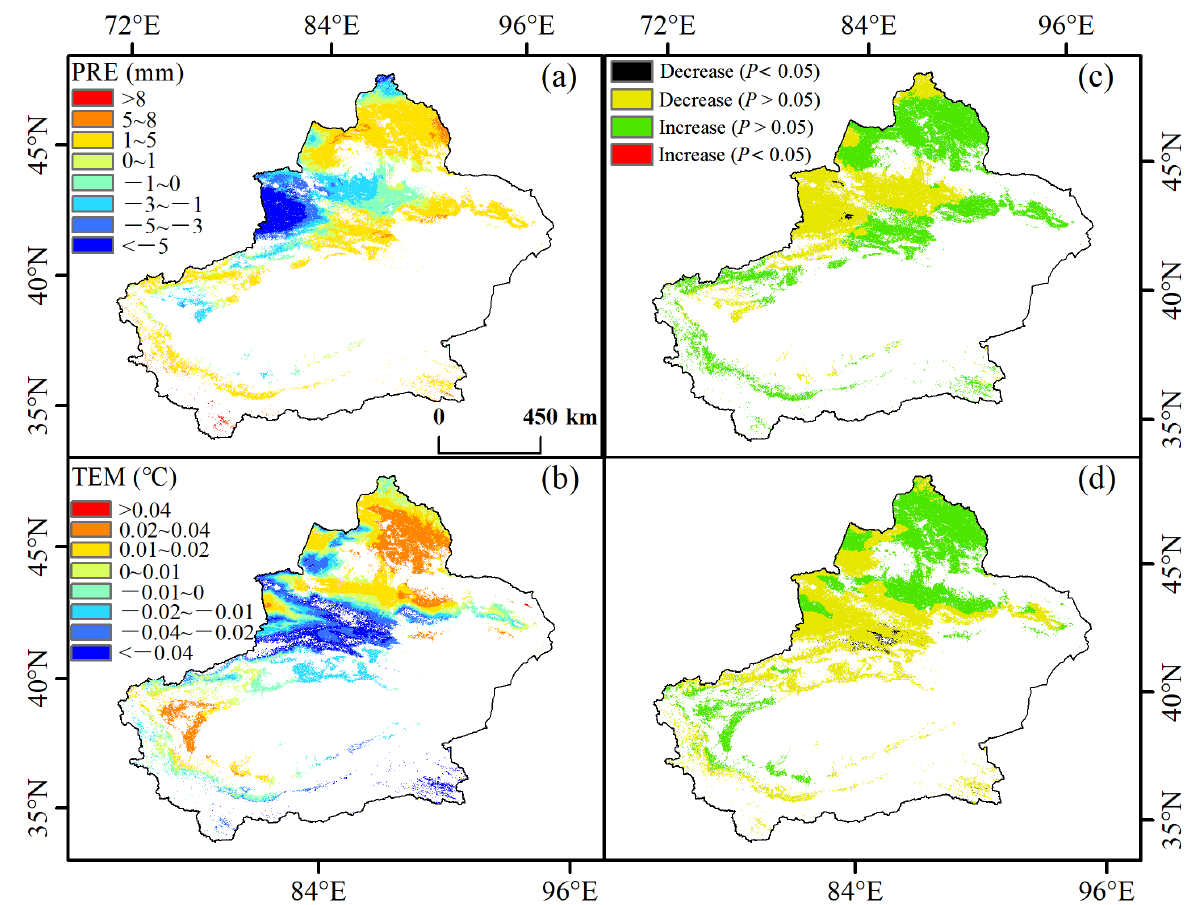
Figure 5. The maps show the results for the Theil–Sen median trend of ( a ) PRE, ( b ) TEM and the Mann–Kendall test of ( c ) PRE, ( d ) TEM from 2001 to 2015.